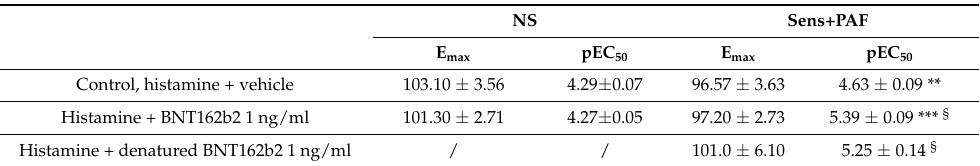
Table 2. Effect of BNT162b2 and mRNA denaturation on the pharmacological characteristics of CRC to histamine in NS and sens+PAF isolated airways.